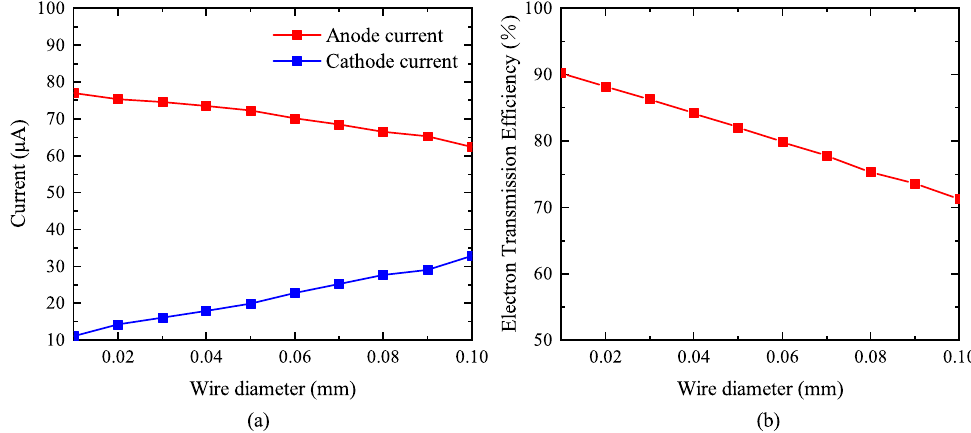
Figure 3. ( a ) The effect of grid wire diameter on cathode current and anode current. ( b ) The effect of grid wire diameter on electron transmission efficiency.